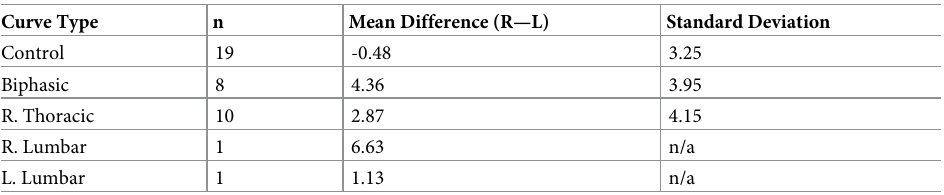
Table 3. Measurements by curve